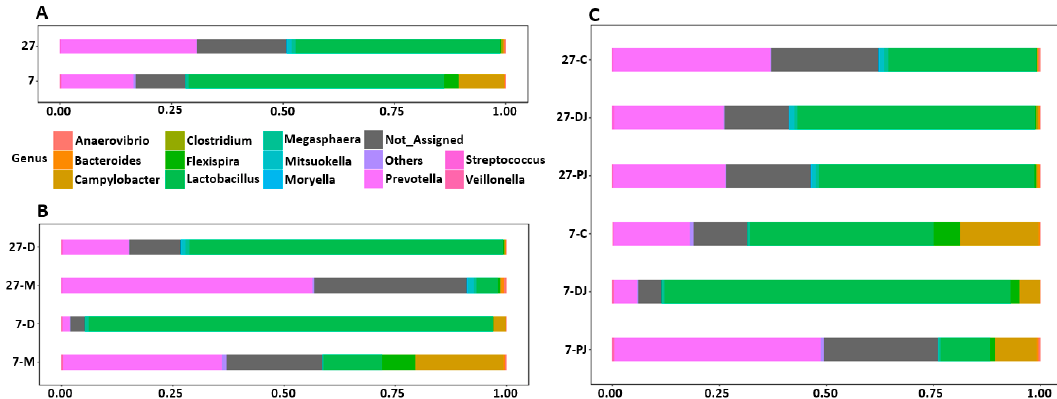
Figure 2. Relative abundance of different genera at post-weaning ages ( A ), different locations ( B ), and different regions of GIT ( C ). The 7 and 27 represent 7 and 27 days, respectively, after weaning; M and D represent mucosa and digesta samples, respectively; PJ, DJ, and C represent proximate jejunum, distal jejunum, and mid-colon, respectively. Not_Assigned represents the sequence reads that were not assigned at the genus level but assigned at the higher taxonomic level, whereas Others represents the bacterial phyla whose counts were lower than 500.